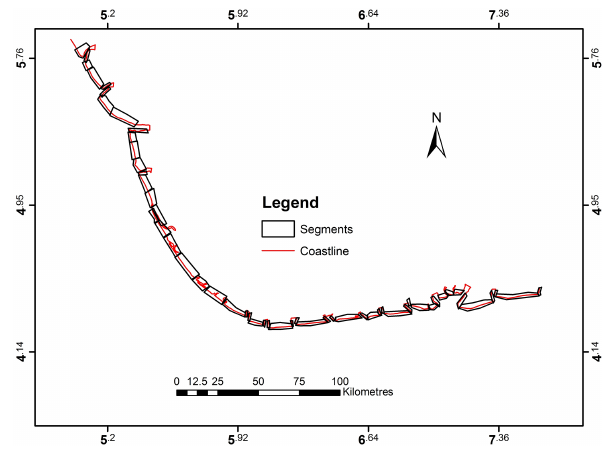
Figure 4. The 54 Niger Delta coastal segments assessed for vulner- ability to